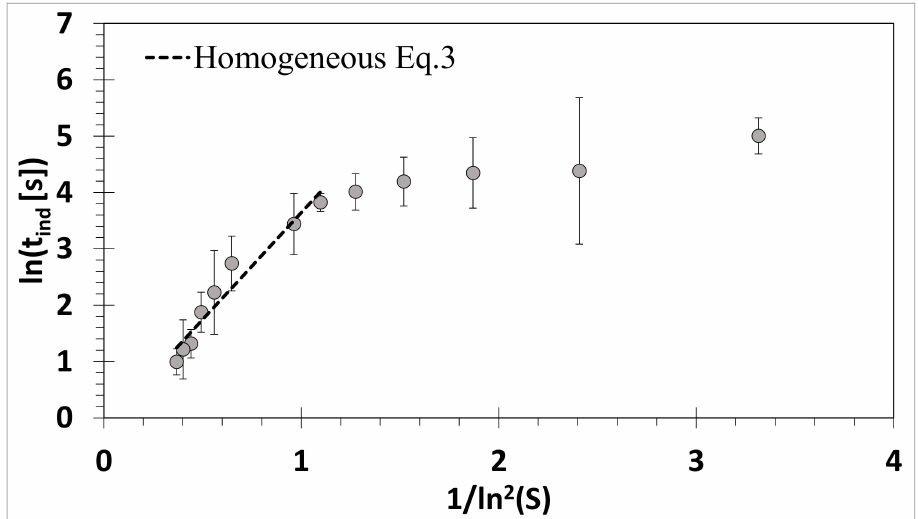
Figure 3. ln( t ind ) in the absence of ultrasound plotted as a function of 1/ln 2 ( S ) showing two linear regions denoting the homogeneous and heterogeneous nucleation. Equation (3), which is only valid for homogeneous nucleation, is fitted to the data. A stirring speed of 100 rpm was